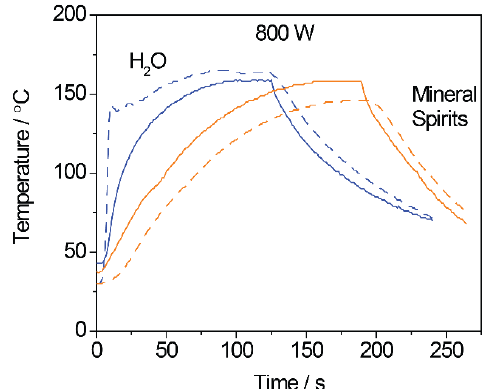
Figure 5. Temperature vs time plots of microwave heating of water (blue) and mineral spirits (orange) to 150 ˝ C at 800 W. The dashed lines indicate the temperatures recorded by the internal fiber-optic thermometer and the solid lines are the temperatures read by the external infrared (IR) sensor.